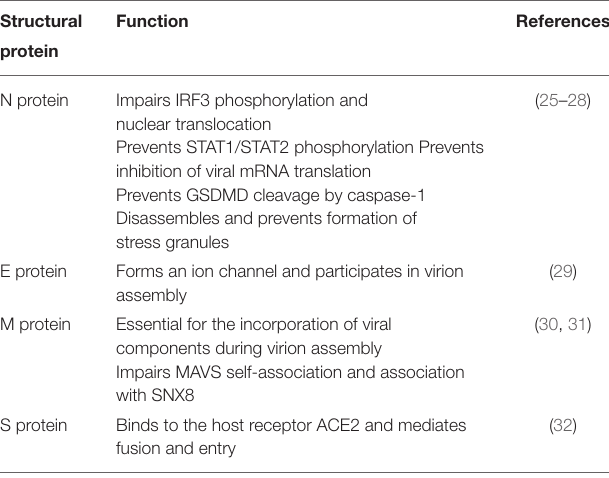
TABLE 1 | Structural proteins encoded by SARS-CoV-2 genome and their functions.